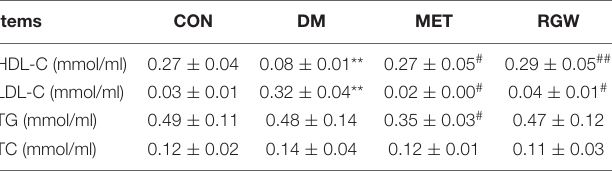
TABLE 4 | Hepatic biochemical parameters of rats in different groups after being treated for 21 days ( n = 8). Items CON DM MET RGW